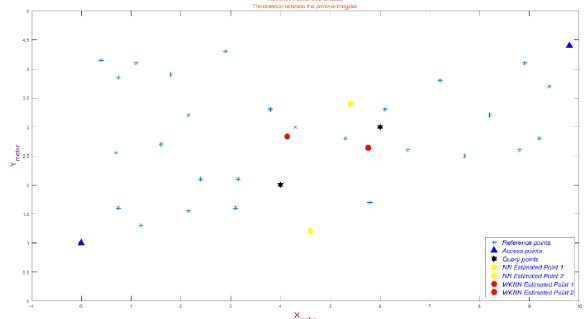
Figure 6 . A view of determining the position of the target points by different methods in the second scenario (Blue stars are reference points, triangles are access points, black stars are target points, yellow circles are estimated points from NN method and red circles are